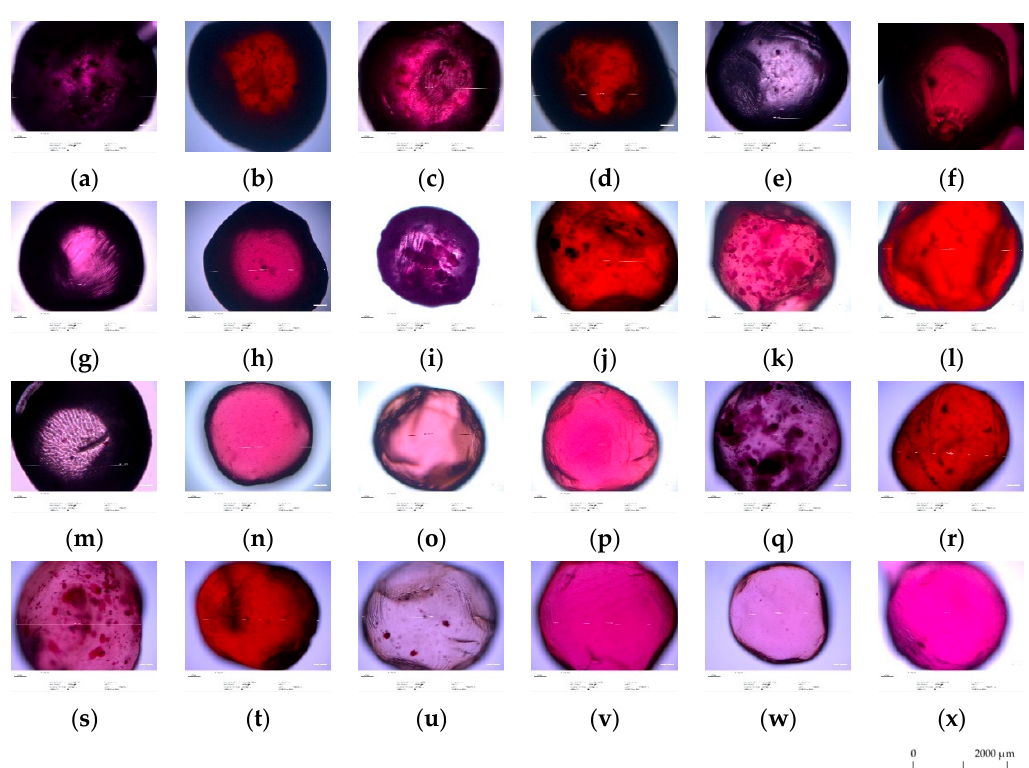
Figure 2. Microscopic images of microspheres coating chokeberry powders, made of various coating materials: ( a )